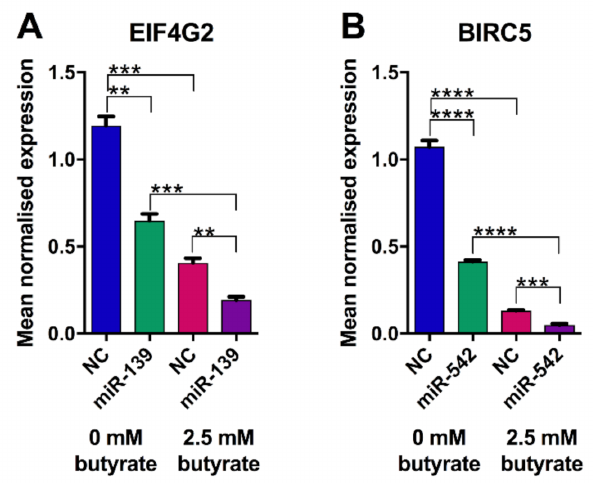
Figure 12. Real-time RT–PCR analysis of miRNA target gene expression in HCT116 cells treated with butyrate for 24 h. mRNA levels of ( A ) EIF4G2 and miR-542 predicted target gene ( B ) BIRC5 in HCT116 cells transfected with miRNA or NC mimics for 48 h, followed by 24 h of treatment with 0 mM or 2.5 mM butyrate, over a 72 h post-transfection period. The mean mRNA levels ± SEM ( n = 3) are represented, and their expression is normalized to the geometric mean of three reference genes, ACTB , B2M and GAPDH . Significant values are indicated by ** p < 0.01, *** p < 0.001, **** p <